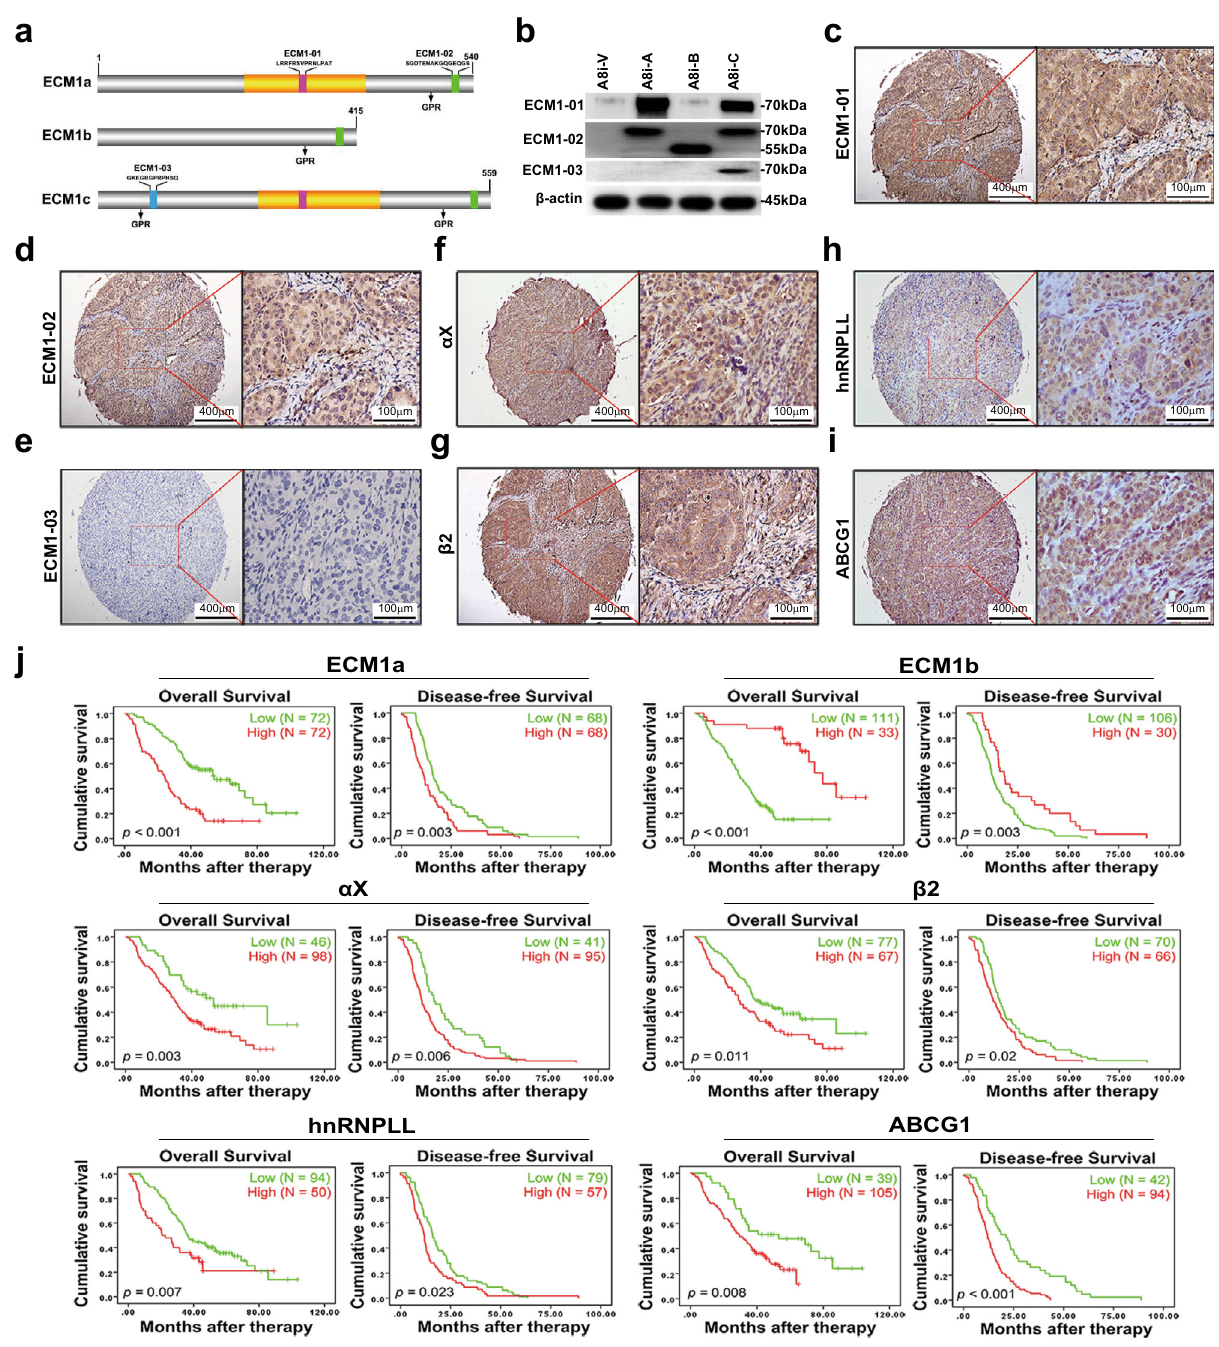
Fig. 8 Correlations of ECM1a, ECM1b, integrin α X, integrin β 2, and hnRNPLL levels with cancer patient survival. Design of antibodies recognizing ECM1 subtypes ( a ) and detection of ECM1 subtypes in HeyA8 cells expressing ECM1 shRNA and further transfected with vector (A8i-V), ECM1a (A8i-A), ECM1b (A8i-B), or ECM1c (A8i-C) cDNAs by WB analysis with speci fi c antibodies ( b ). c – i Representative images from the TMA. IHC showed different levels of ECM1a ( c , detected with the ECM1-01 antibody), ECM1a or ECM1b ( d , detected with the ECM1-02 antibody), ECM1c ( e , detected with the ECM1- 03 antibody), integrin α X ( f ), integrin β 2 ( g ), hnRNPLL ( h ), and ABCG1 ( i ); bars = 400 or 100 μ m indicating different magni fi cations of the tissues. j A TMA consisting of 150 high-grade serous OC tissues and 30 normal ovarian tissues was stained by IHC for analysis of ECM1 subtypes, integrin α X, integrin β 2, hnRNPLL, and ABCG1 expression. The level of each protein was classi fi ed as high or low expression. Survival analysis conducted with Kaplan – Meier plots showed that poor OS and DFS were associated with high expression of ECM1a, integrin α X, integrin β 2, ABCG1, and hnRNPLL, whereas favorable OS and DFS were associated with high expression of ECM1b. Two-tailed t -test was used for survival